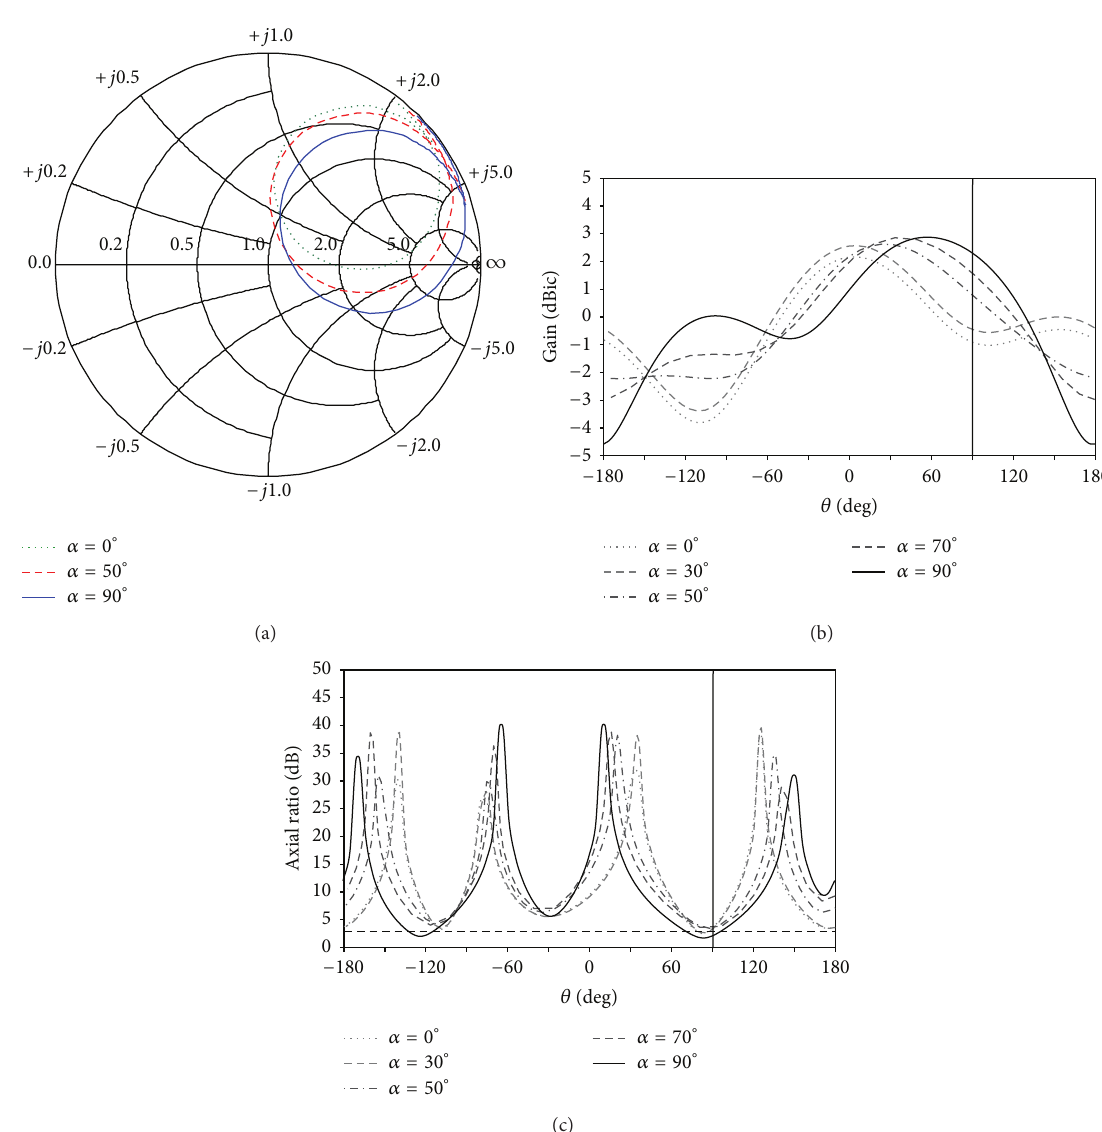
Figure 8: Simulated results of (a) input impedance characteristics with 𝛼 , (b) antenna gain pattern, and (c) AR pattern of the proposed antenna in y-z plane at 925 MHz as a function of the bending angle 𝛼 ( 𝜙 = 90 ∘